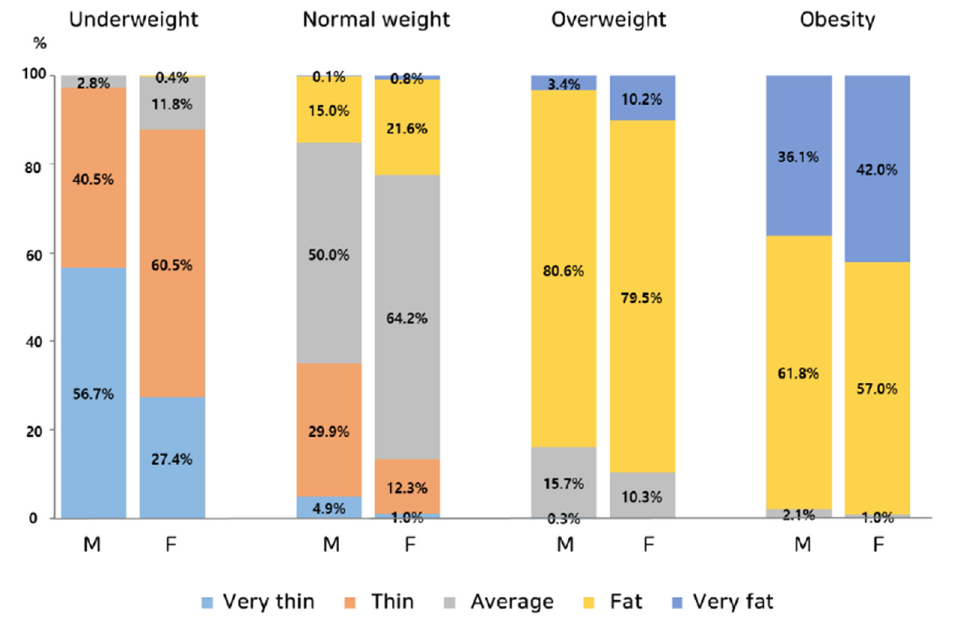
Figure 1. Distribution of self-perceived weight status according to actual weight status (represented by BMI): underweight (below the 5th percentile), normal (from the 5th to the 85th percentile), overweight (from the 85th to the 95th percentile), and obesity (above the 95th percentile); M, male; F, female.